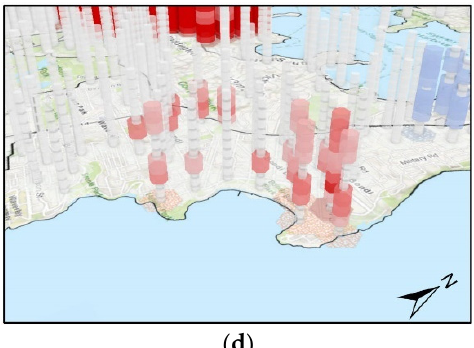
Figure 17. ( a ) On-premises spatio-temporal analysis 2012–2021; ( b ) On-premises space-time cube 3D visualisation northern section; ( c ) On-premises space-time cube 3D visualisation CBD section; ( d ) On-premises space-time cube 3D visualisation eastern section.